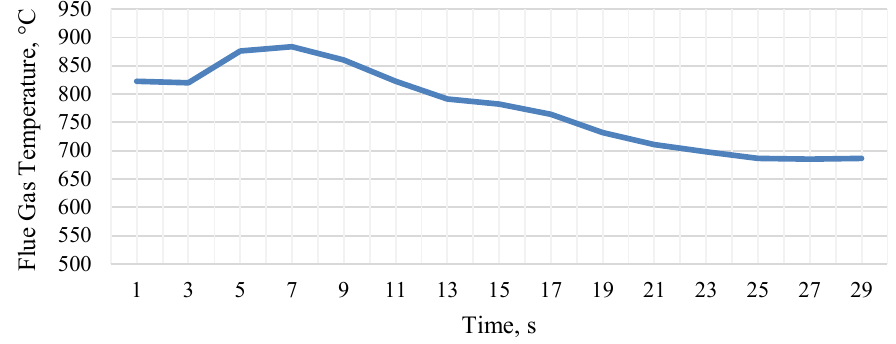
Fig. 6. Flue Gas Temperature Observation 3.